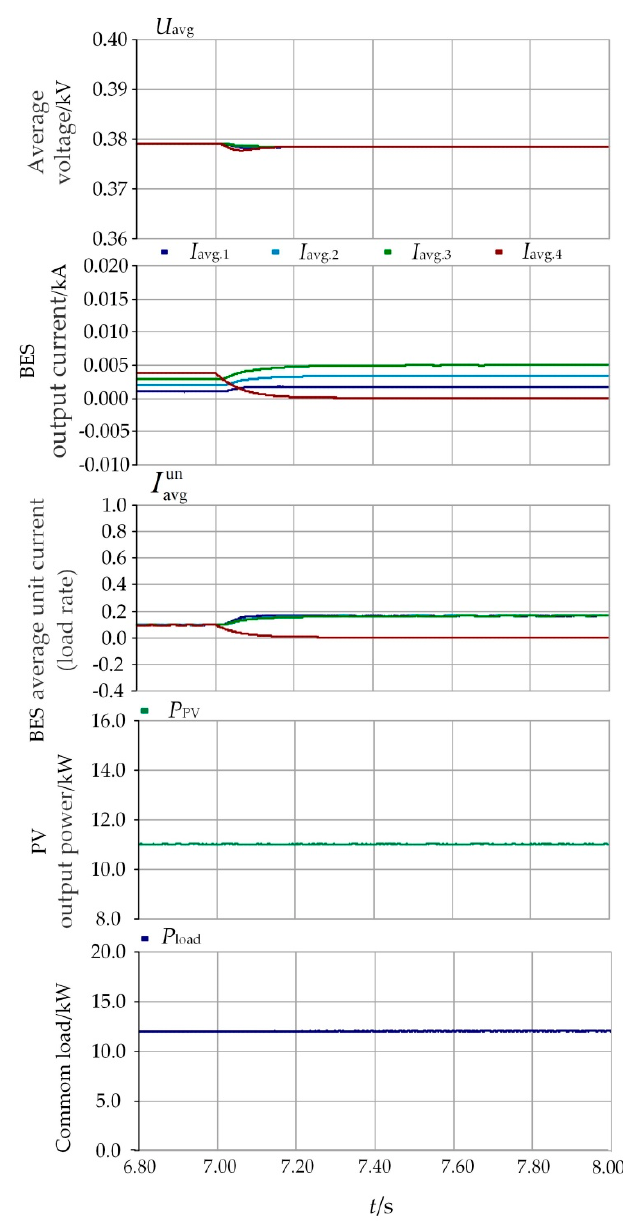
Figure 17. Simulation waveform of Situation 5.